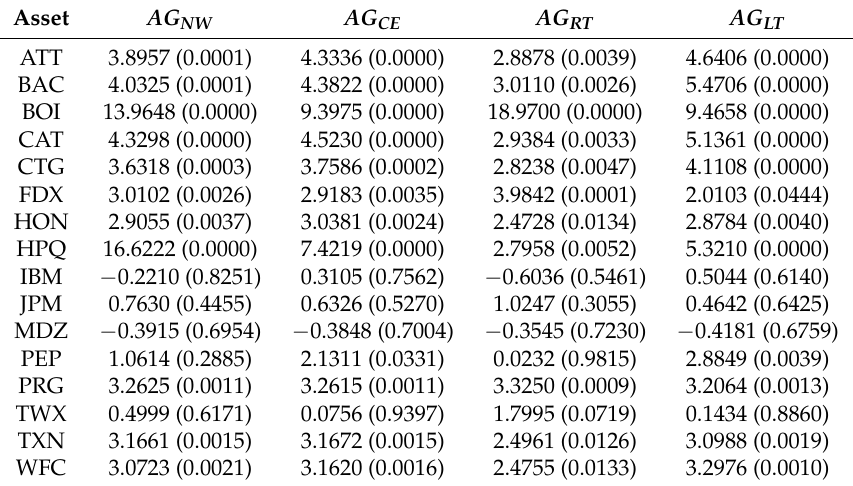
Table 5. Amisano–Giacomini test for the single asset analysis.